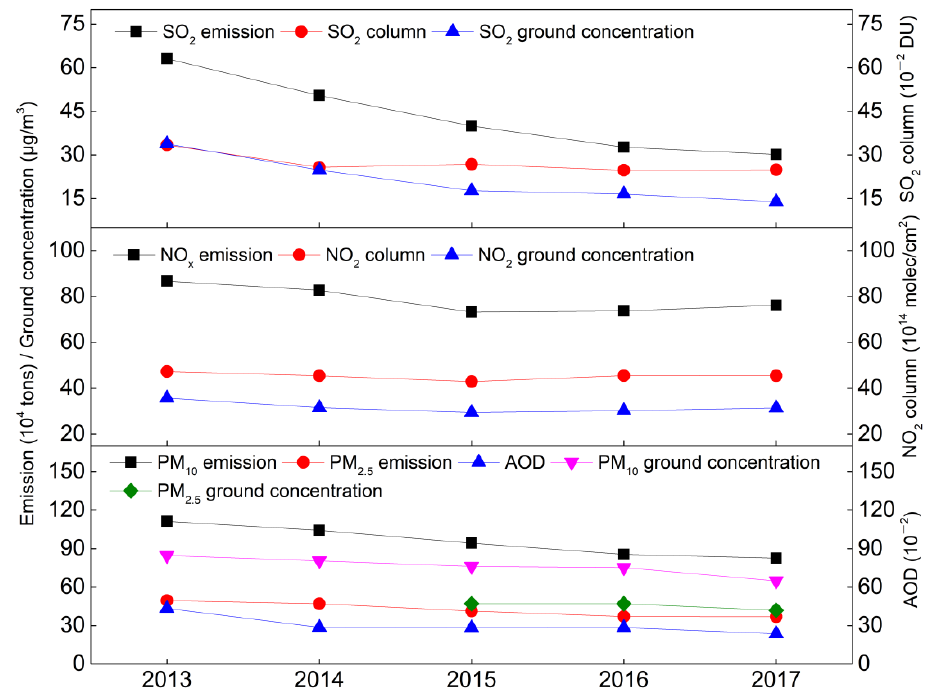
Figure 15. Trends in emissions, satellite data, and ground concentrations.